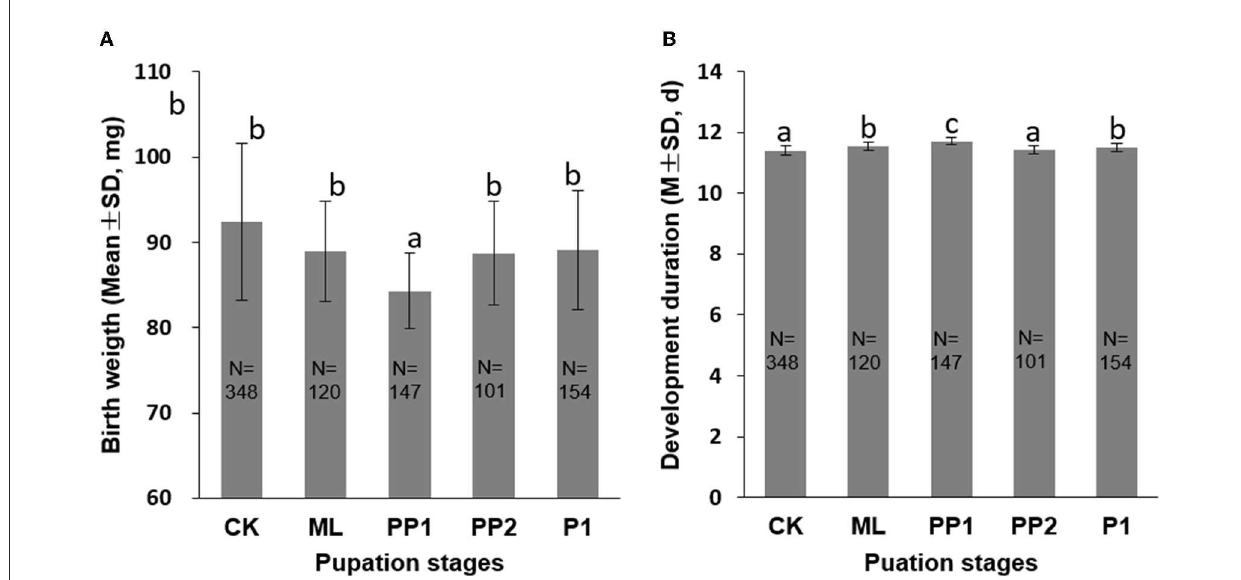
FIGURE2 Birth weight (A) and development duration (B) of honeybee broods exposed to 40 ◦ C for 16h. CK, control group; ML, mature larva; PP1, the first day of prepupa; PP2, the second day of prepupa; P1, the first day of the pupa. The different letters in the lowercase indicate a significant difference at the P < 0.01 level. The numbers in the columns indicate sample sizes.